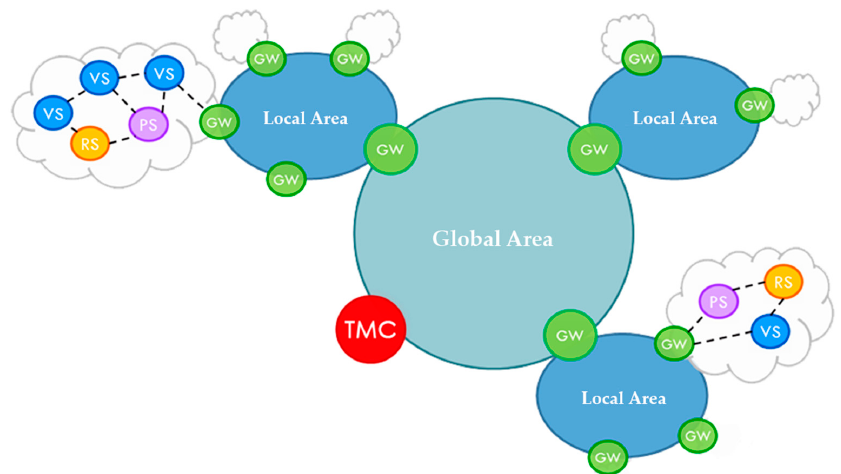
Figure 1. Global system architecture.